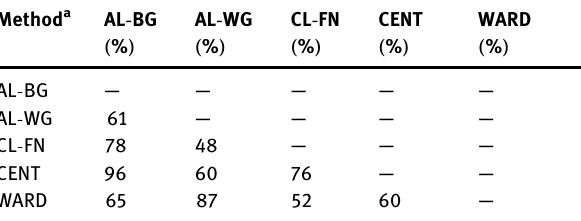
Table 6: Comparison of the solutions obtained with the hierarchical methods Method a